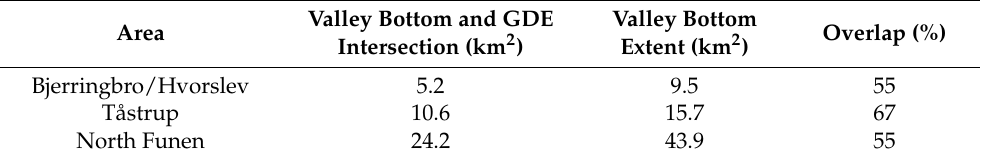
Figure 11. Validation of the developed river valley bottom delineation tool showing the areas of overlap between the delineated river valley bottom and GDE, and the extent to which the river valley bottom covers for the three validation areas. Table 2. Validation results showing the valley bottom and Groundwater Dependent Ecosystems (GDE) intersection area, valley bottom extent, and